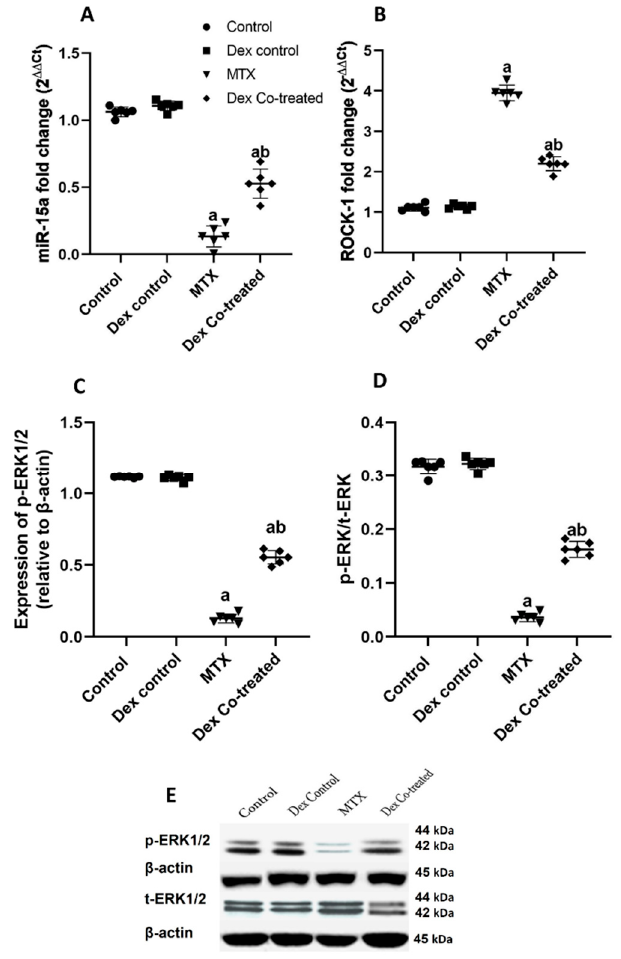
Figure 5. Effects of MTX and Dex on miR-15a, ROCK-1, and ERK1/2. ( A , B ) The MTX-treated group has a significant decrease in miR-15a and an increase in ROCK-1 expression compared to the nor- mal control group. However, Dex co-treatment significantly reverses the MTX effect by signifi- cantly increasing miR-15a and lowering ROCK-1 expression levels when compared to the MTX-treated group. ( C , D ) In comparison to the normal control group, the MTX-treated rats show significant decreases in p-ERK and the ratio of p-ERK to t-ERK. On the other hand, Dex co-treatment restores ERK1/2 activation as demonstrated by a rise in p-ERK as well as in the p-ERK/t-ERK ratio, compared to the MTX group. ( E ) Representative Western blot of the expression levels of p-ERK and t-ERK. Data are expressed as mean ± SD, n = 6. (a) Significant difference from control, and (b) significant difference from MTX. Significance level is set at p < 0.05. One-way ANOVA and Tukey’s post hoc test were used in the statistical analysis. As ROCK-1 is well established as an inhibitor of the ERK1/2/CREB signaling path- way, we sought to assess the total and phosphorylated forms of these transcription fac- tors in our experimental rat model. In comparison to the normal control group, the MTX-treated rats showed significant decline in ERK1/2 activation as evidenced by a de- crease in phosphorylated ERK1/2 (p-ERK) by 88.45%, where the ratio of p-ERK1/2 to total ERK1/2 (t-ERK1/2) declined by 88.52% ( p < 0.05) (Figure 5C–E). Dex co-treatment, on the other hand, restored ERK1/2 activation, which had been severely suppressed by MTX, as demonstrated by a 4.15-fold rise in p-ERK level compared to that in the MTX group, along with a 4.18-fold increase in the p-ERK/t-ERK ratio ( p < 0.05) (Figure 5C–E). We also detected that MTX administration induced significant decrease in the expression levels of total CREB (t-CREB), phosphorylated CREB (p-CREB), and p-CREB/t-CREB ratio by 22.49%, 44.54%, and 26.47%, respectively, when compared to those in the normal control